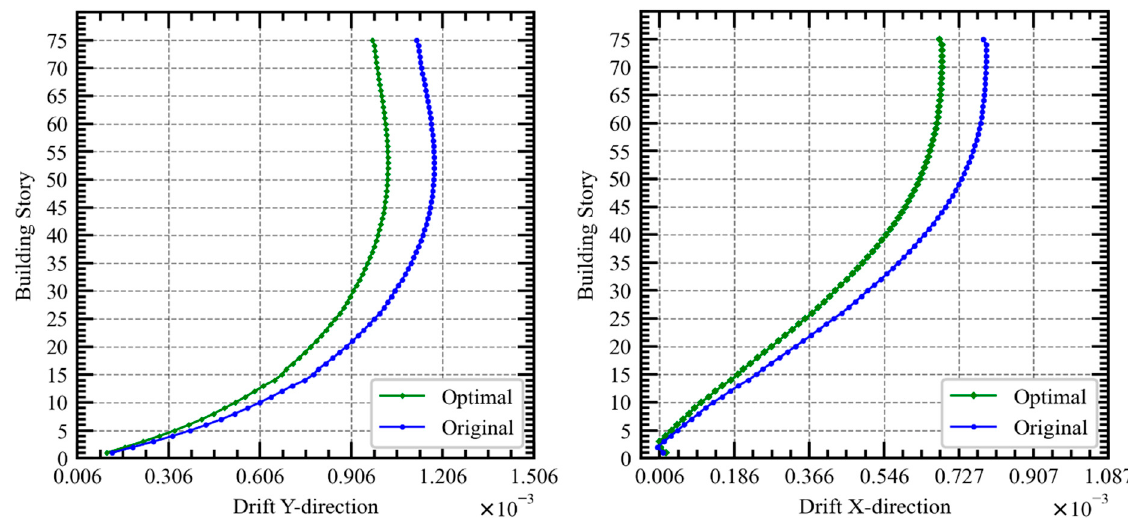
Figure 21. Maximum inter-story drifts.